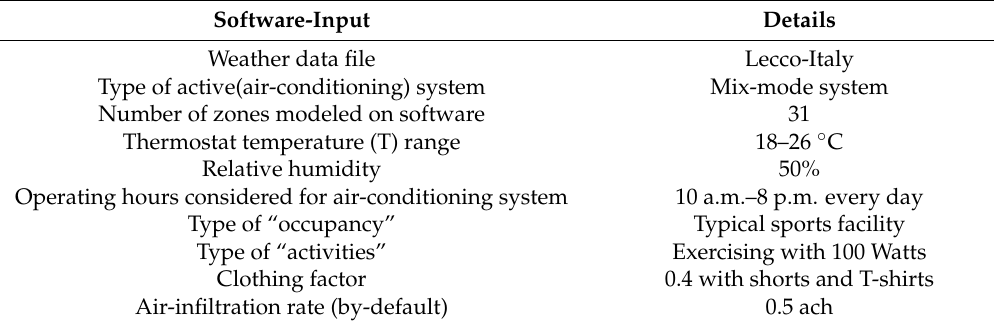
Table 5. Project data on